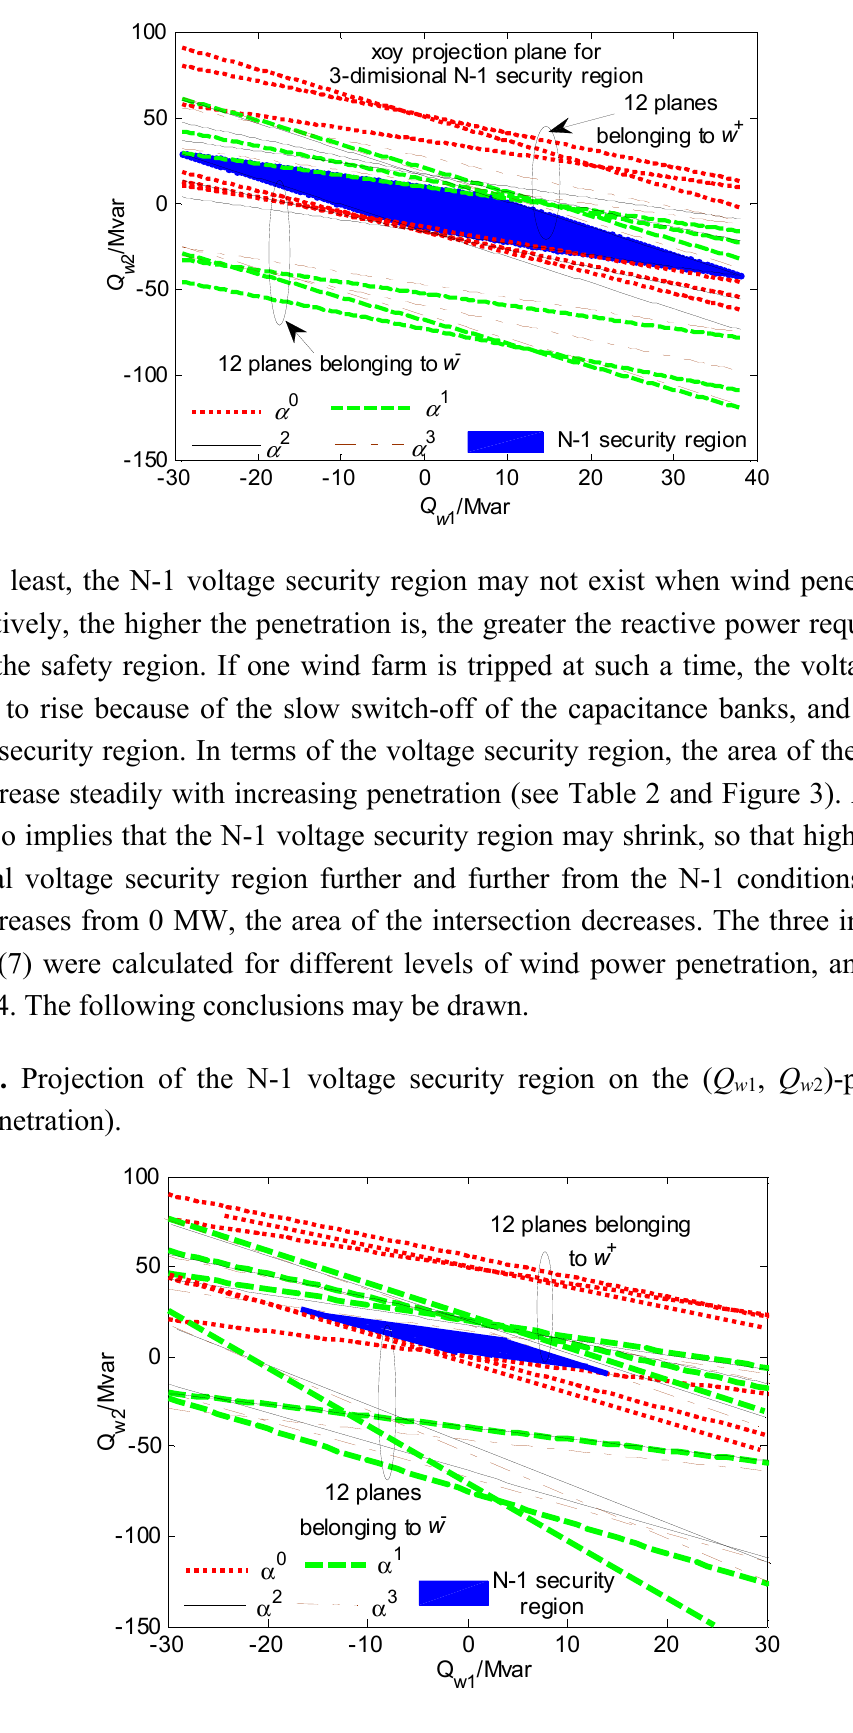
, Q )-plane. α 0 , α 1 , w 1 w 2